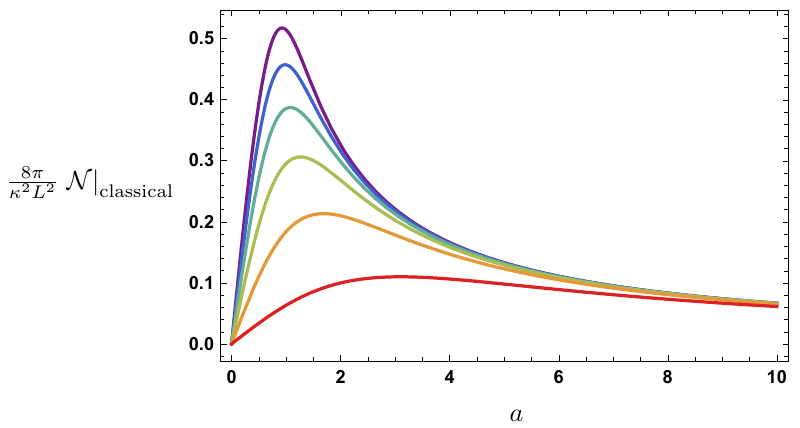
Figure 5 . Noise function from eq. (4.8), written as a function of the rescaled time Nj classical a = t=L , for the same representative values of the temperature as in (cid:12)gure 2. The asymptotic decoherence rate, set by the value of at late times, goes to zero as shown in eq. (4.9). N where j 1 is the (cid:12)rst spherical Bessel function of the (cid:12)rst kind. Performing the